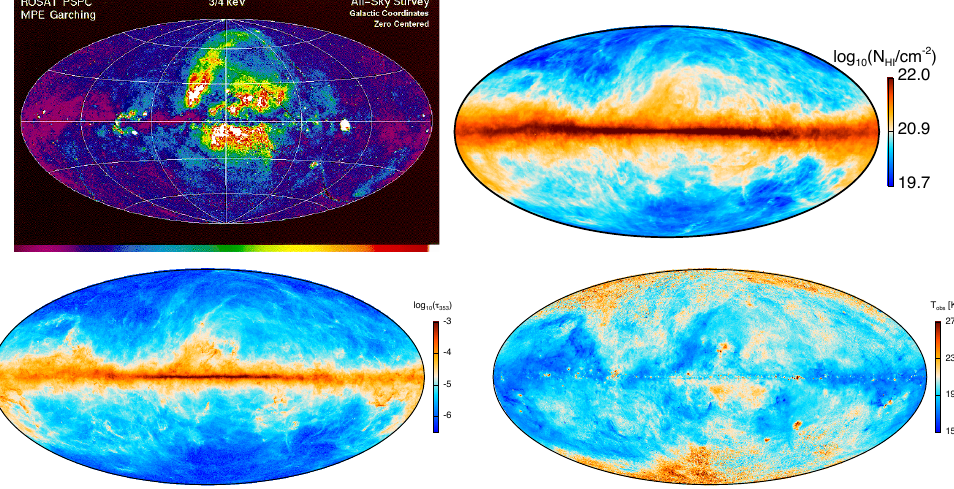
Figure 6. ( Upper Left ) ROSAT 3/4 keV image of the NPS [61], (the map is taken from http://www. mpe.mpg.de/xray/wave/rosat/publications/highlights/all$_$sky$_$survey.php); ( Upper Right ) low velocity HI all sky map— | v LSR | < 35 km s − 1 (taken from [62]), originally from 21 cm LAB all-sky survey by Kalberla et al. [63]; ( Lower Left ) Planck dust optical depth at 353 GHz τ 353 (from [62]); ( Lower Right ) Planck dust temperature map (from [62]). There is the north-east offset of the low N HI (cid:39) 20.3), and low 353 GHz optical depth (log τ 353 (cid:39) − 5) tongues column density 21 cm (log 10 10 with respect to the NPS. It is also clear that τ 353 and dust temperature T d do anti-correlate mostly through over the whole field and particularly in the low- τ 353 tongue (see discussion in text)